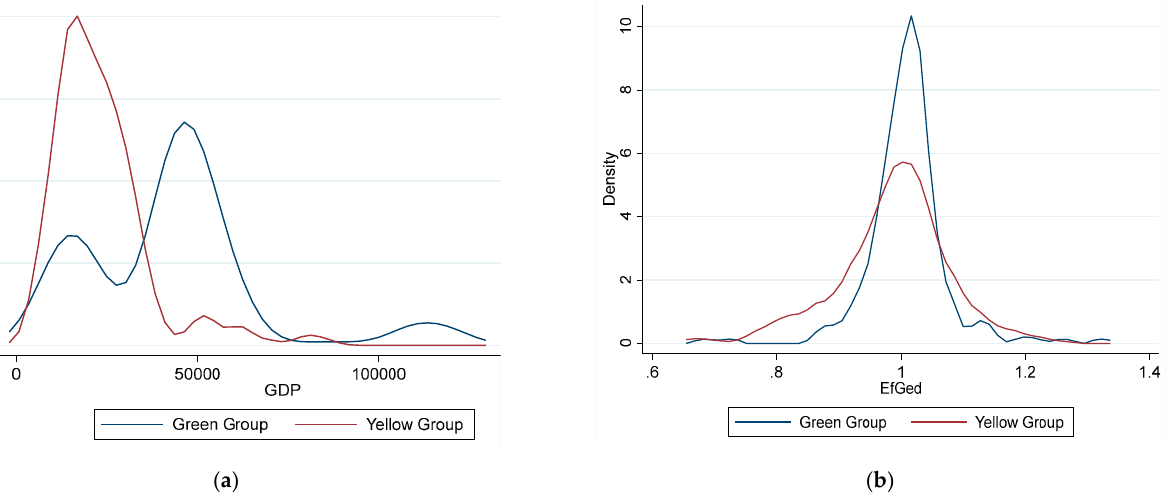
Figure 1. Visualisation of empirical findings of the Gaussian kernel density function for GDP ( a ) and EfGed ( b ).